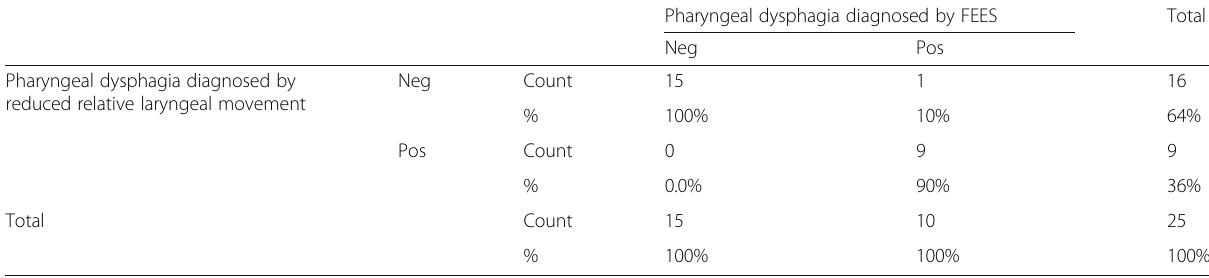
Table 2 Pharyngeal dysphagia diagnosed by the reduced relative laryngeal movement ( ≤ 40%) as compared to FEES which was used as the reference modality